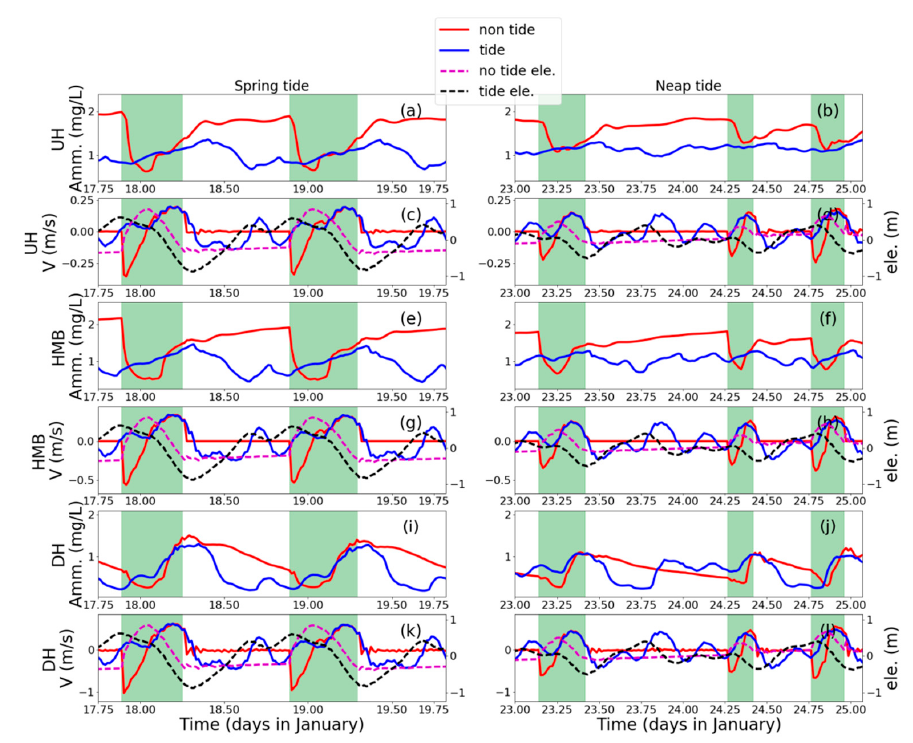
Figure 4. Time series of velocity and ammonia concentration in 3 cross-sections: downstream part relative to HMB (UH) ( a – d ), HMB tide gate) ( e – h ), and downstream part relative to HMB (DH) ( i – l ) (Figure 1). Two semi-diurnal cycles, in the spring phase (17.75th–19.75th of January) and neap phases (23rd–26nd of January), were plotted on the left panels and right panels. Values in the tide-receiving scenario were plotted in blue curves and the non-tide-receiving scenario in red curves, with tide gate opening periods marked out by green shadows. Tidal elevations of HMB were plotted together with velocity to show the tidal phases (c, d, g, h, k, l). For velocity, seaward is a positive value and vice versa.